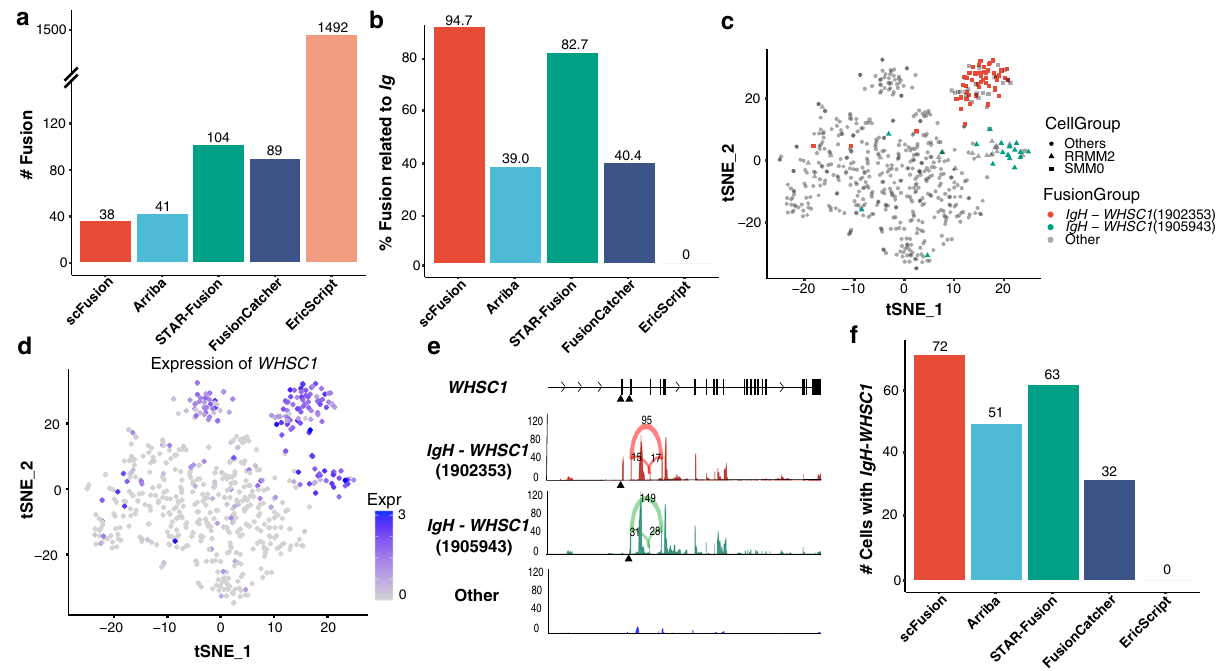
Fig. 7 The MM scRNA-seq data. a The number of detected gene fusions by the fi ve methods. b The percentage of IgH-related fusions in fusions detected by the fi ve methods. c The tSNE plot of all MM single cells. The cells with two IgH-WHSC1 fusions are colored in the plot. The cells from patient RMM2 and SMM0 are marked by triangle and rectangle, respectively. d The expression of WHSC1 shown in the tSNE plot. e The mean read depth of WHSC1 at different locations for the cells with the two IgH-WHSC1 fusions and the cells without the fusions. The black triangles indicate the breakpoints of the two fusions. The supporting number of splicing junctions are also shown in the plot (the numbers above the arcs). The read depth of a single cell at a location is calculated as the number of reads covering the location per million. The mean read depth is the average depth of all cells in a group. f The barplots of numbers of cells with the IgH-WHSC1 fusions by different algorithms. Source data are provided as a Source Data fi le.